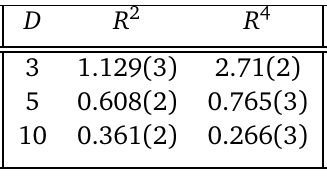
Table 4: The results obtained for various D matrices YM models are given for λ = 1 with N =